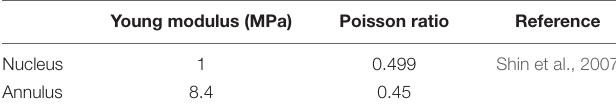
TABLE 2 | Young Modulus and Poisson ratio used for the finite element model of the disc. Young modulus